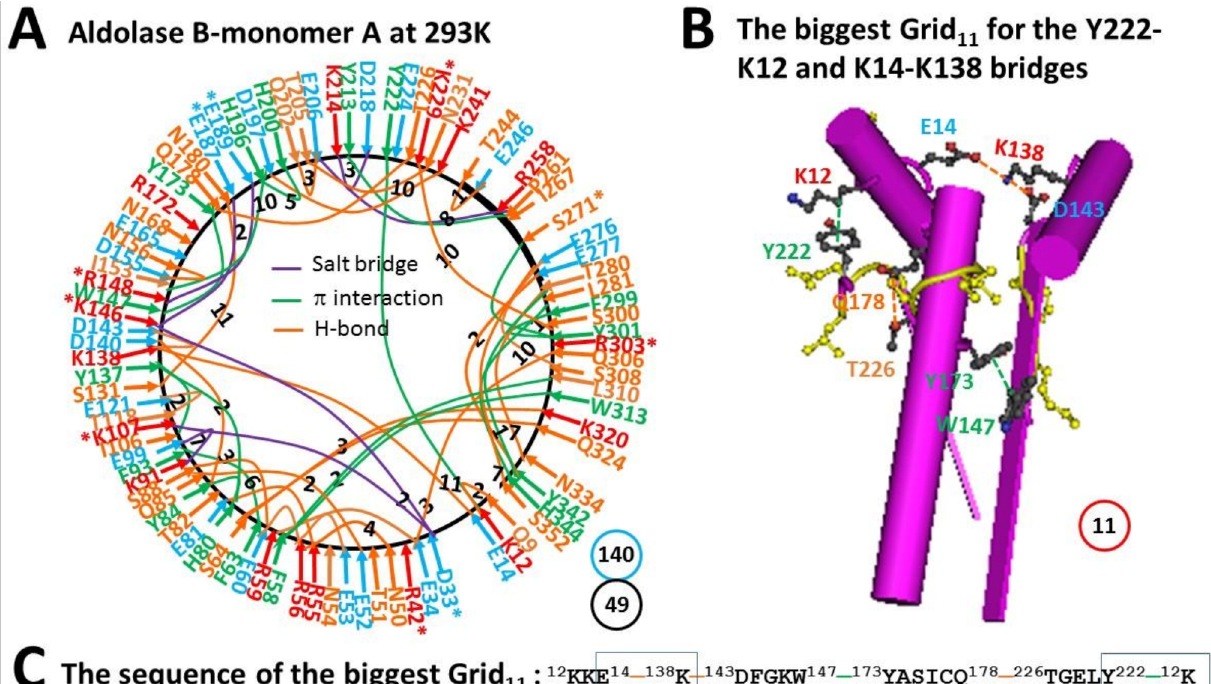
Figure 6. The grid-like non-covalently interacting mesh network along the single polypeptide chain of ligand-free monomer A in the aldolase B tetramer at room temperature (293 K). ( A ) The topological grids in the systemic fluidic grid-like mesh network. The X-ray crystallographic structure of monomer A in aldolase B at room temperature (293 K) (PDB ID, 1QO5) was used for the model [9]. Salt bridges, π interactions, and H-bonds between pairing amino acid side chains along the single polypeptide chain from T8 to H344 are marked in purple, green, and orange, respectively. The grid sizes required to control the relevant non-covalent interactions were calculated and labeled in black. The total grid sizes and grid size-controlled non-covalent interactions along the single polypeptide chain are shown in the blue and black circles, respectively. ( B ) The structure of the biggest Grid 11 . The grid size is shown in a red circle. ( C ) The sequence of the biggest Grid 11 to control the K12-Y222 CH- π interaction and the E14-K138 H-bond in blue